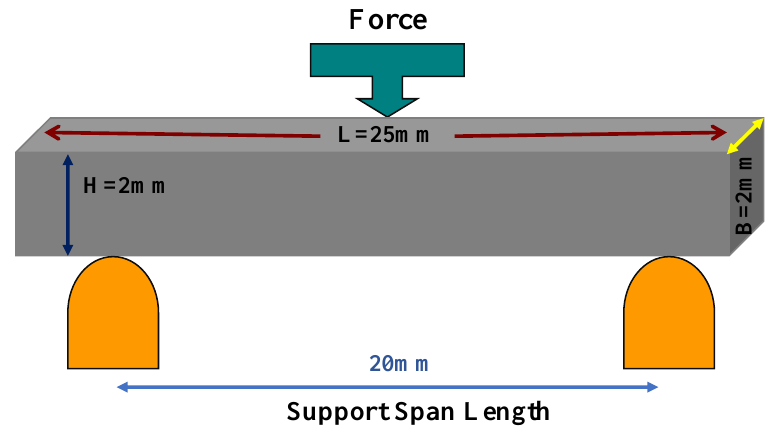
Figure 1. Schematic representation of the three-point flexural test. The formula for the calculation of Flexural strength (FS) σ = 3Fl/2bh 2 where σ denotes the flexural strength (MPa), F is the maximum load (N) applied to the specimen, l is the space between the supports (mm), and b and h are the width (mm) and height (mm) of the specimen,